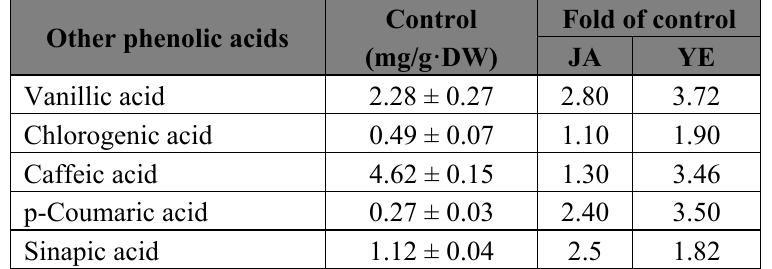
Table 2. Individual response of phenolic acids subjected to